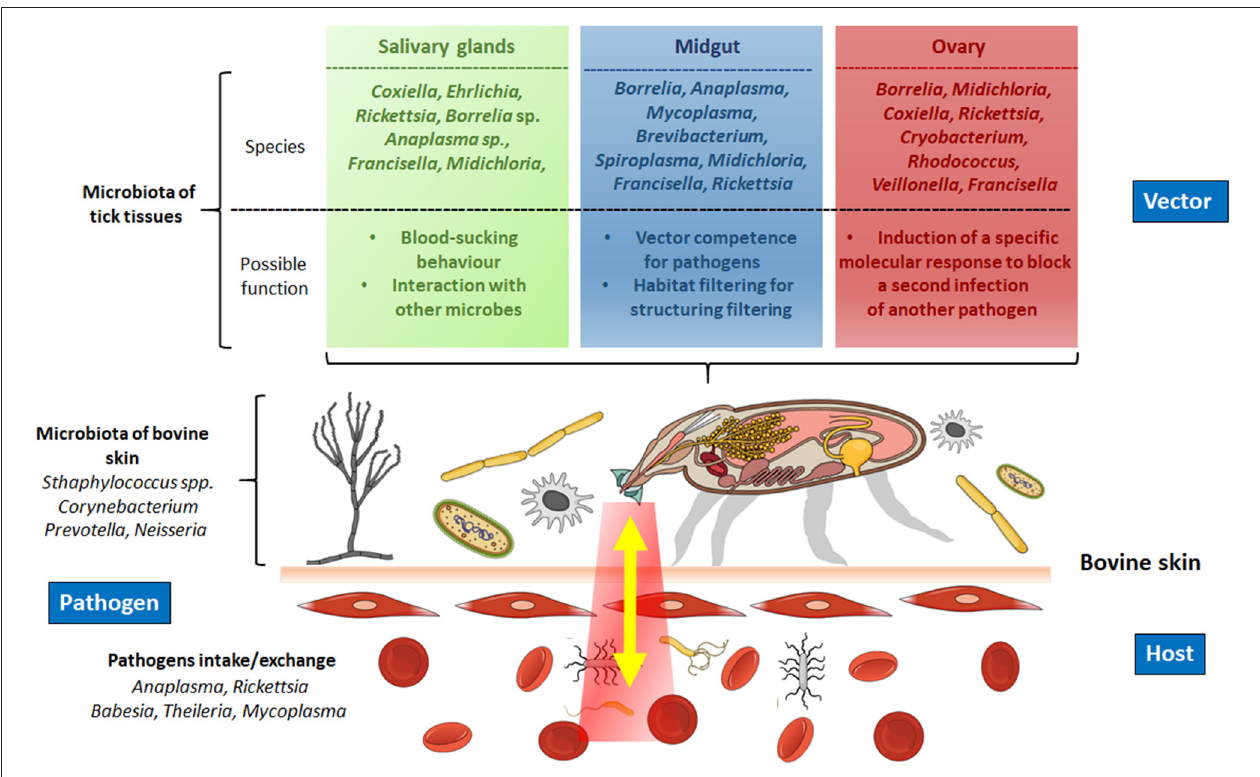
FIGURE 2 | Modulation of the interaction microbiota–pathogen–tick–host during blood intake. Upper panel, the microbiota of the tick interacts with the pathogens ingested during blood intake in different organs of the tick (salivary glands, gut, ovary). The microbiota of these organs promotes the establishment and reproduction of the pathogens and, in some cases, in the vectorial capacity to transmit the definitive host. Lower panel, interaction of the microbiota of the bovine blood with the microbiota of the tick. The microbiota of the bovine’s skin also interacts with the tick. Created in the Mind the Graph platform.